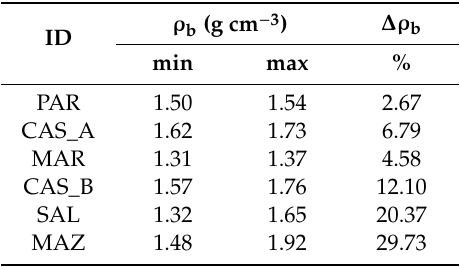
Table 5. Values of minimum and maximum bulk density and corresponding variations for undisturbed